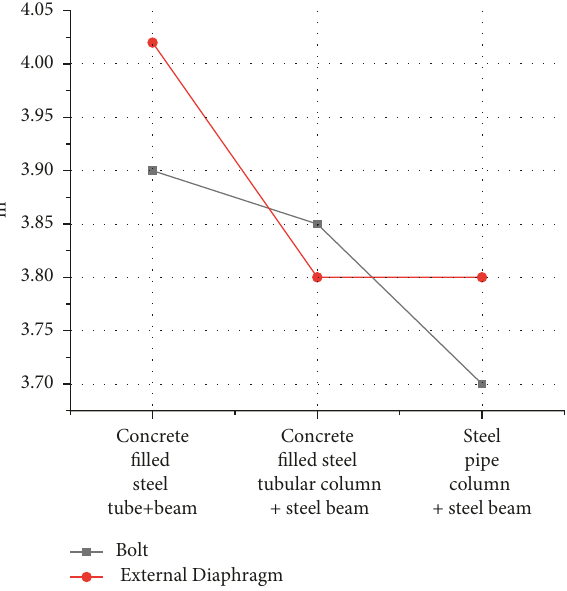
Figure 9: Displacement ductility data diagram of each